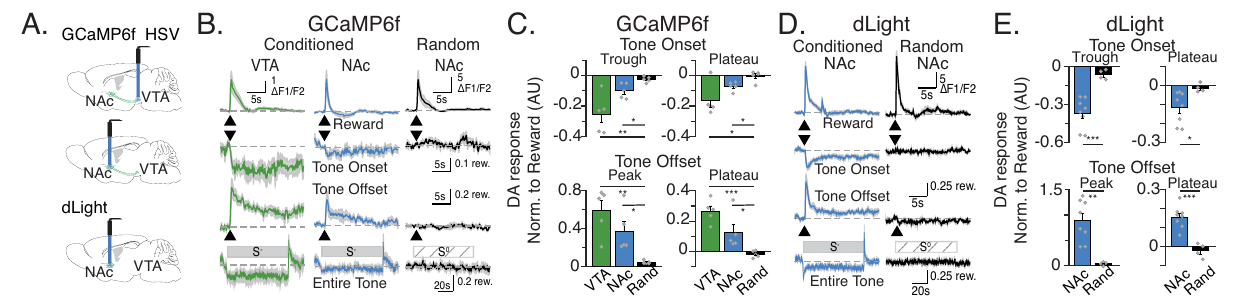
Fig. 2 Changes in reward availability are encoded by dopamine transients. A Schematic of virus injection and fi ber implant locations for photomotery experiments. B Average GCaMP6f responses to Reward (dipper), Tone onset, Tone offset and entire tone after training in the Conditioned group in VTA (left, green) the conditioned group in NAc (middle, blue) and Random group in NAc (Right, black). N = 5 mice per condition. C Quanti fi cation of ( B ). S − onset “ troughs ” : minimal valuewithin 2s ofToneonset. Toneoffset “ peaks ” : maximal value within2s of offset;Plateau DAlevels:average oflast 60s ofS − for toneonsetand 5 – 7s after S − offset; trials with rewards within 5s of offset were excluded. Unpaired two-tailed t test results for VTA vs. Random: tone onset trough t (8) = 3.97, p = 0.0041, tone offset peak t (8) = 5.001, p = 0.0011, tone onset plateau t (8) = 3.249, p = 0.0117, tone offset plateau t (8) = 8.138, p <0.0001. NAc vs. Random: tone onset trough t (8) = 3.199, p = 0.0143, tone offset peak t (8) = 3.149, p = 0.0136, tone onset plateau t (8) = 3.299, p = 0.0126, tone offset plateau